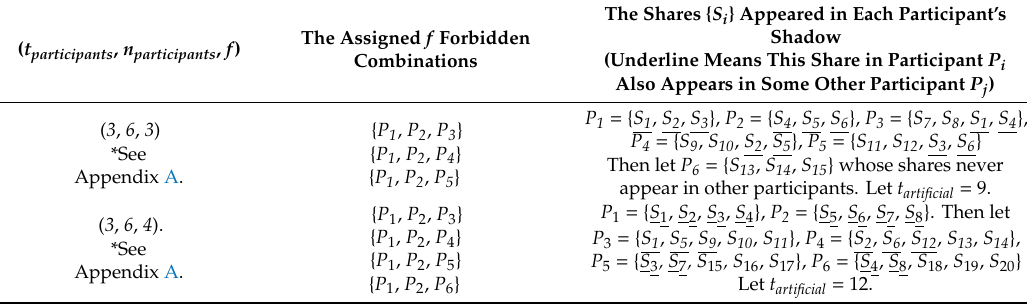
Table 1. Some examples of sharing with forbidden